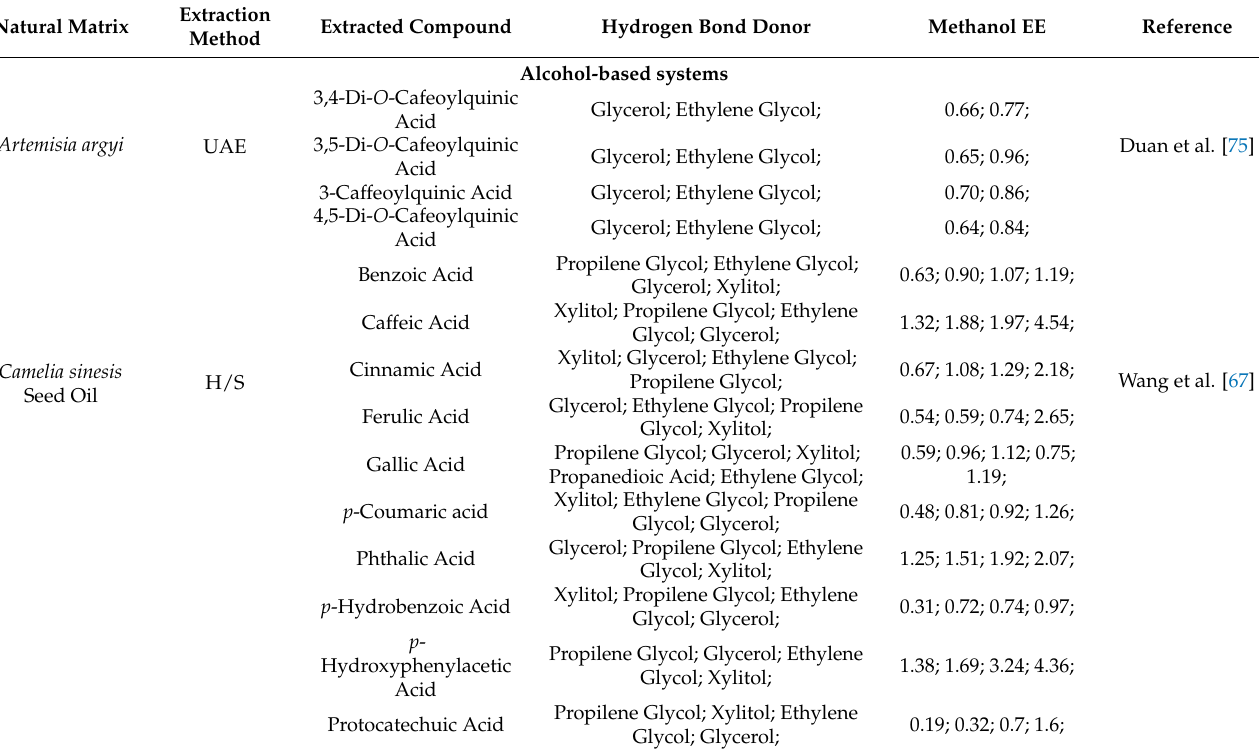
Table 6. Correlation between the natural matrix, extraction method, and DES based on ammonium salts (choline chloride and betaine) and the effect of different HBDs on the extraction efficiency of different phenolic acids compared with ethanol